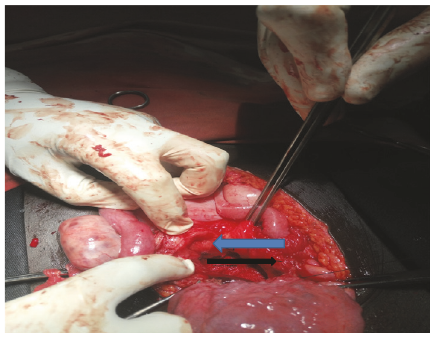
Figure 4: The gross picture of the cervix (blue arrow) and anterior vagina (black arrow) after excision of the mass.